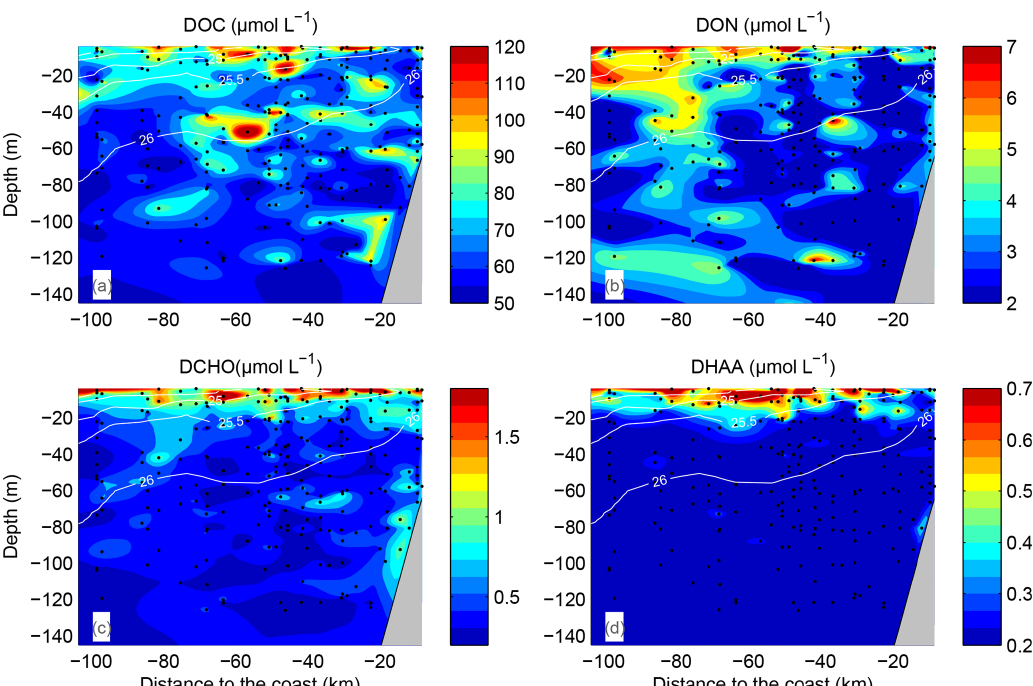
Figure 3. Dissolved organic carbon (DOC) (a) , dissolved organic nitrogen (DON) (b) , dissolved combined carbohydrates (DCCHO) (c) and dissolved hydrolysable amino acids (DHAA) (d) distributions over the water column. Data from all transects and stations were plotted against distance to coast (kilometres). Space between data points was interpolated by using the TriScatteredInterp function (MATLAB, MathWorks). Isolines represent potential density, averaged over intervals of 10km on the “Distance from the coast” axis and over 1m on the “Depth” axis.